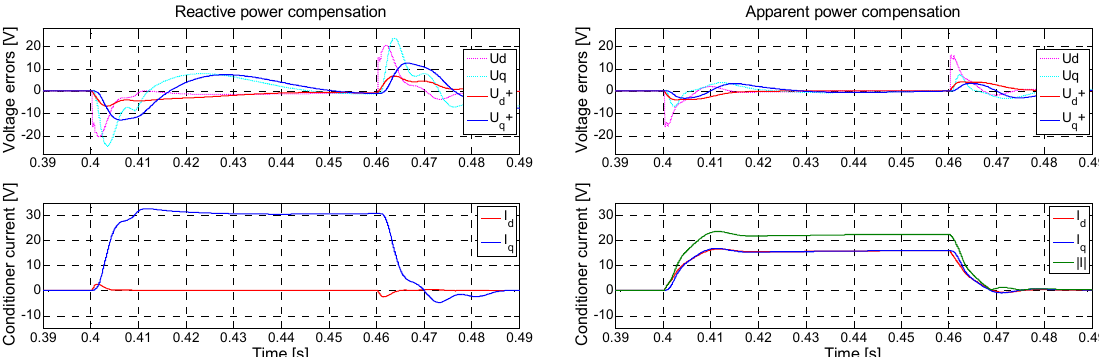
Figure 8. Simulation results of the voltage controller with current minimization method: ( a ) test voltage waveform, ( b ) reactive power compensation and ( c ) proposed apparent power compensation.